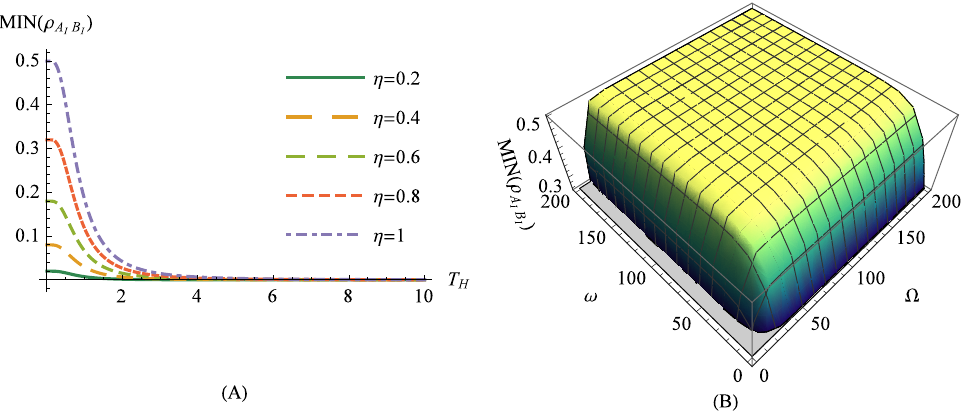
Figure 3. The measurement-induced nonlocality (MIN) as a function of ( A ) the Hawking temperature and ( B ) simultaneously the fermionic ( ω ) and bosonic ( Ω ) frequencies for the physically accessible correlations in the case of the mixed modes ( ρ A ). The results are presented for ( A ) the selected I B I values of the entanglement parameter ( η ) and ( B ) for the fixed entanglement parameter ( η = 1) and the fixed Hawking temperature ( T H =